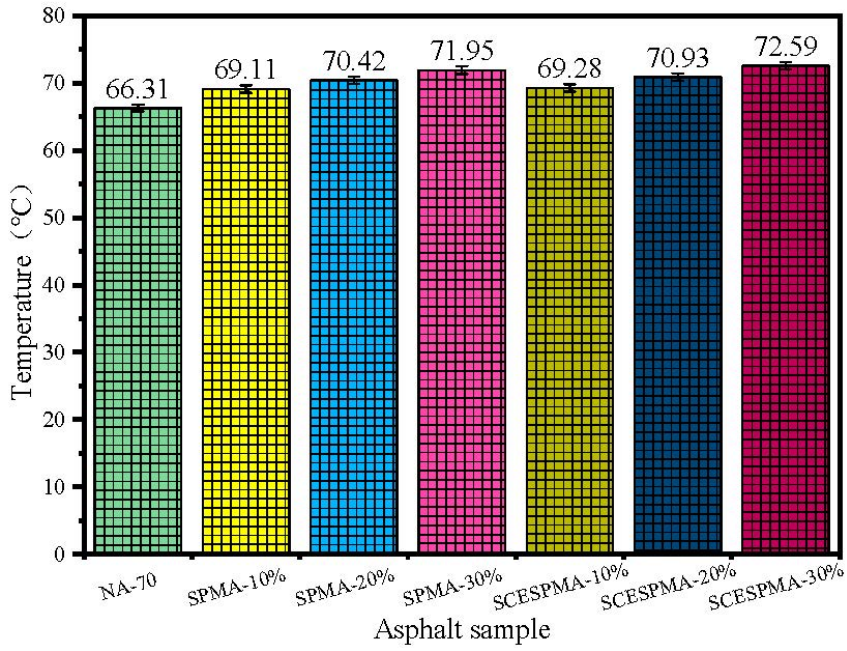
Figure 12. Continuous high-temperature PG analysis of SPMA and